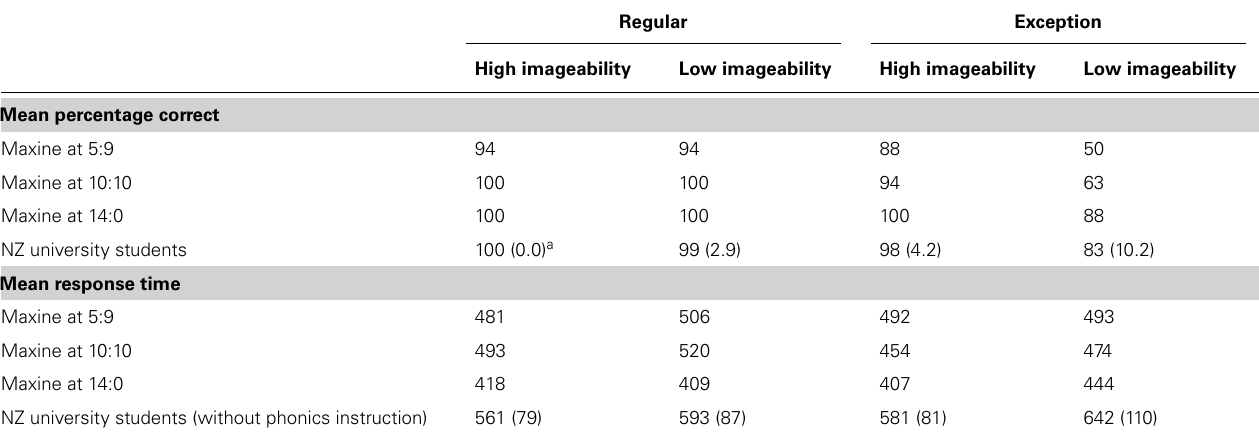
Table 5 | Experiment 3: Mean percent correct and RTs for words varying in regularity of spelling and in imageability for Maxine at 5:9, 10:10 and 14:0, and New Zealand university students without phonics instruction (standard deviation in